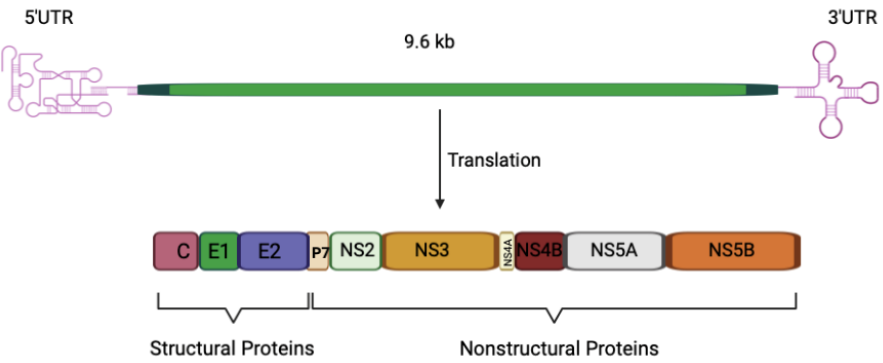
Figure 1. Schematic presentation of HCV genome and polyprotein precursor. The HCV genome encodes a polyprotein of about 3000 amino acids and comprises an open reading frame flanked by 5′ and 3′ untranslated regions (UTRs). Following translation, the core, E1, and E2 proteins, as well as p7, are separated from the polyprotein by cellular peptidase. NS2’s protease activity separates NS2 from NS3, whereas the viral replication components (NS3-NS5B) are separated by the NS3-4A protease. C: core protein; E1 and E2: envelope glycoprotein E1 and E2; NS: nonstructural.